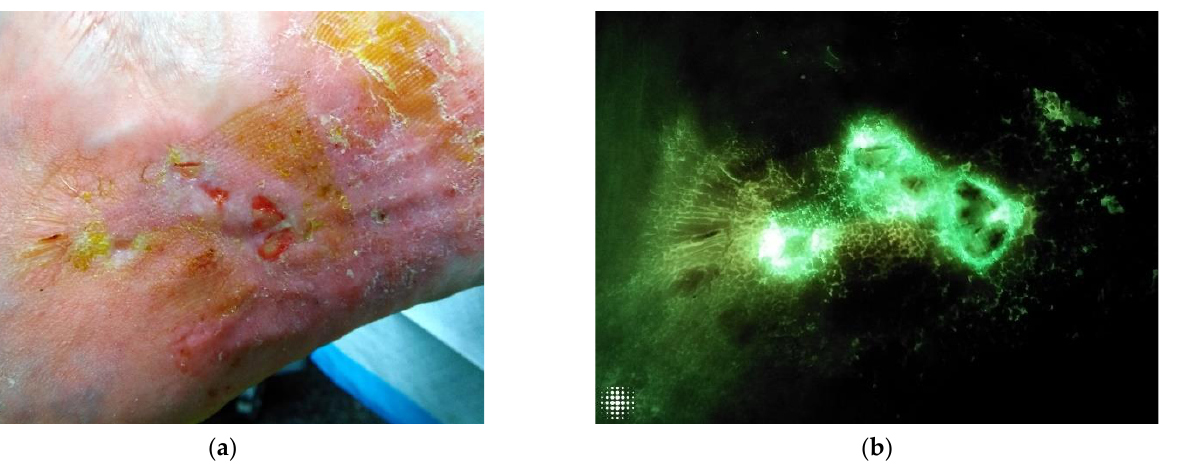
Figure 1. ( a ). A visually innocuous wound on clinical inspection. ( b ) The same wound was assessed under FL-imaging, demonstrating cyan positive signal, indicative of Pseudomonas . This was later confirmed by microbiology.